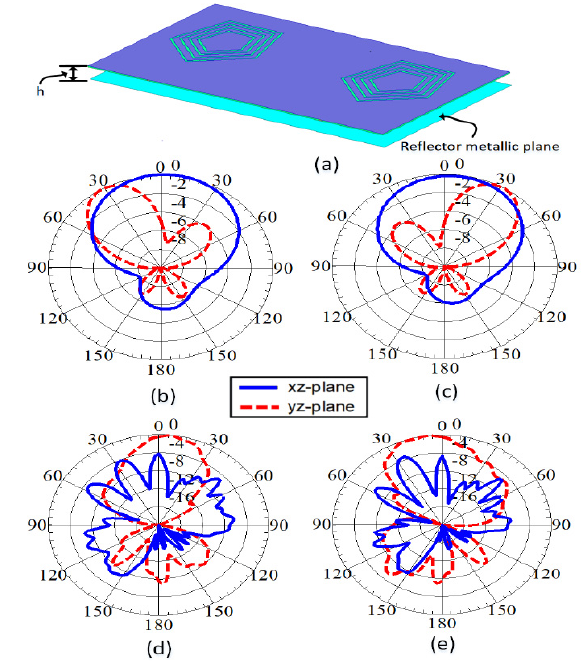
Figure 15. Simulated gain patterns with back-plane reflector: ( a ) Antenna with reflector, ( b ) Ant − 1 at 1.9 GHz, ( c ) Ant − 2 at 1.9 GHz, ( d ) Ant − 1 at 28 GHz, ( e ) Ant − 2 at 28 GHz.